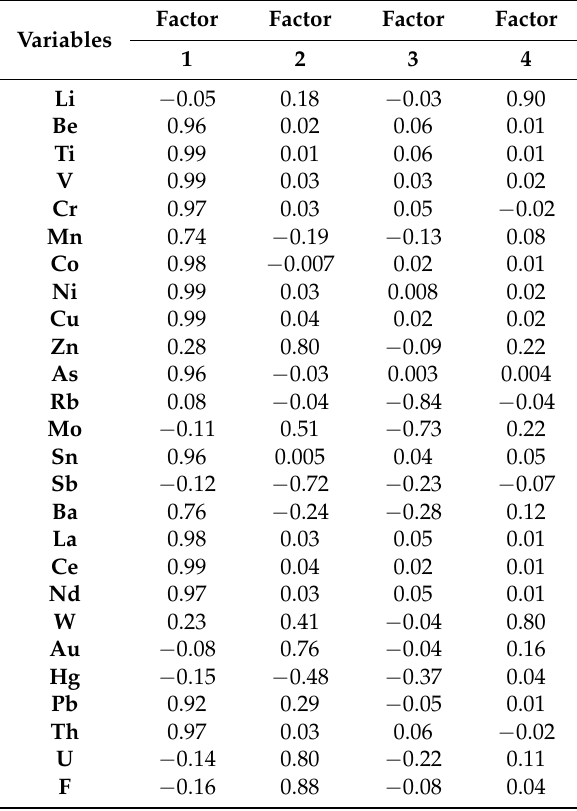
Table 6. Factor loadings for the four first factors with Varimax normalized rotation. Results of